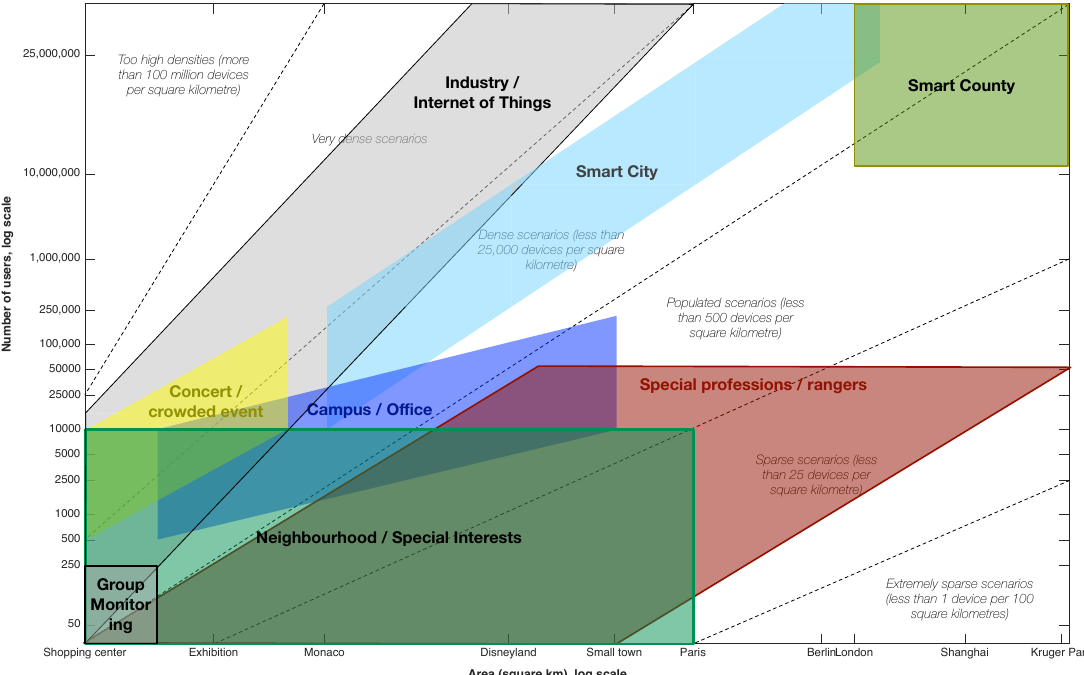
Figure 1. OppNets applications and their node densities. Six different node density areas have been identified and marked with dotted